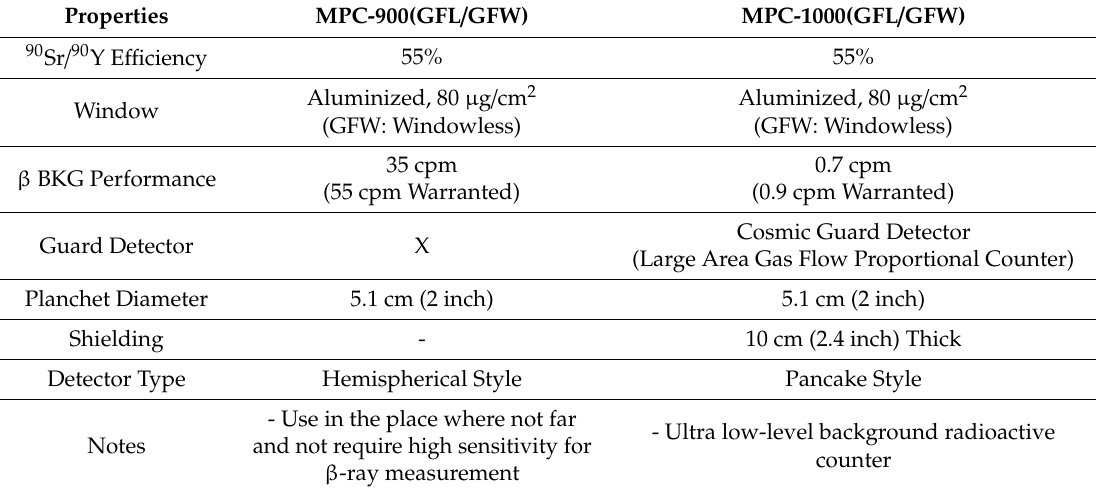
Figure 8. Gas-flow type proportional counter: ( a ) MPC-900-GFL and ( b ) MPC-1000-GFL [71]. Table 7. Compared properties by the Ortec Manual Single Counter.